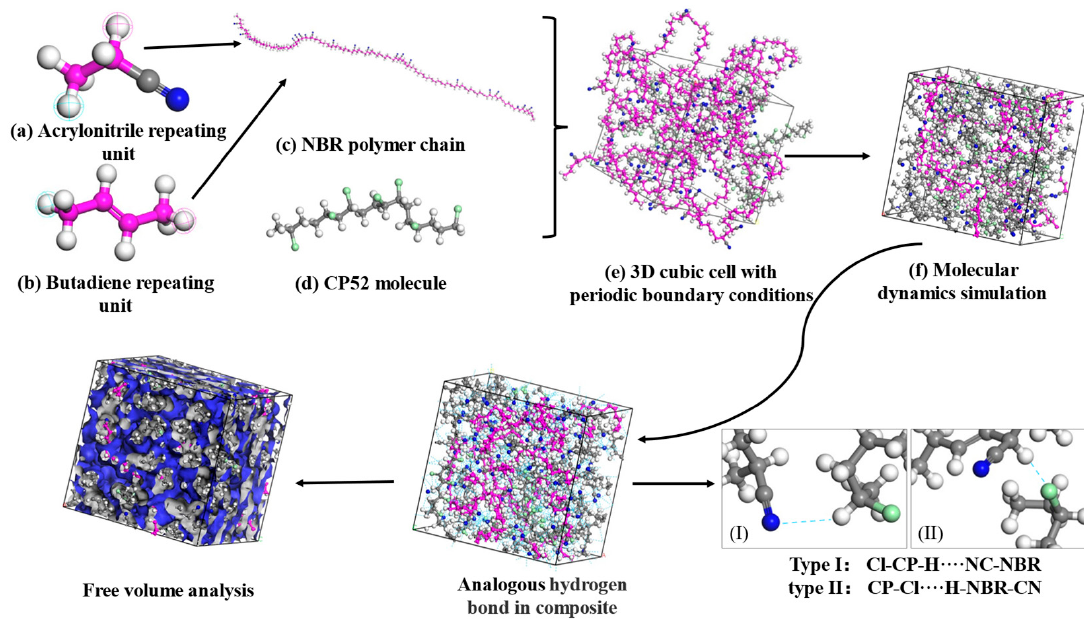
Figure 1. Models for molecular dynamics simulation of CP52/NBR.